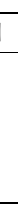
Table 1. Impedance parameter values extracted from the equivalent